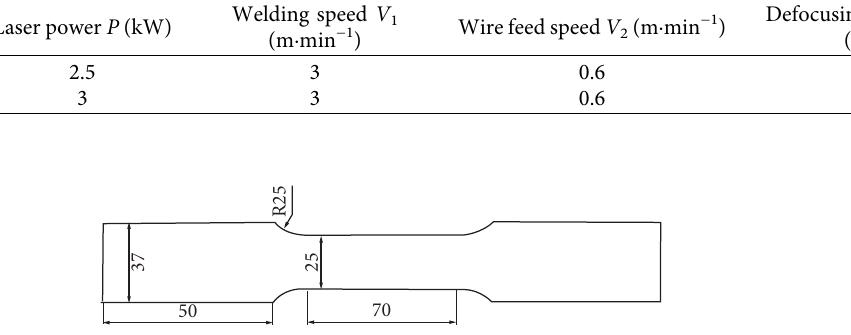
Figure 5: Schematic drawing of drawing sample processing.